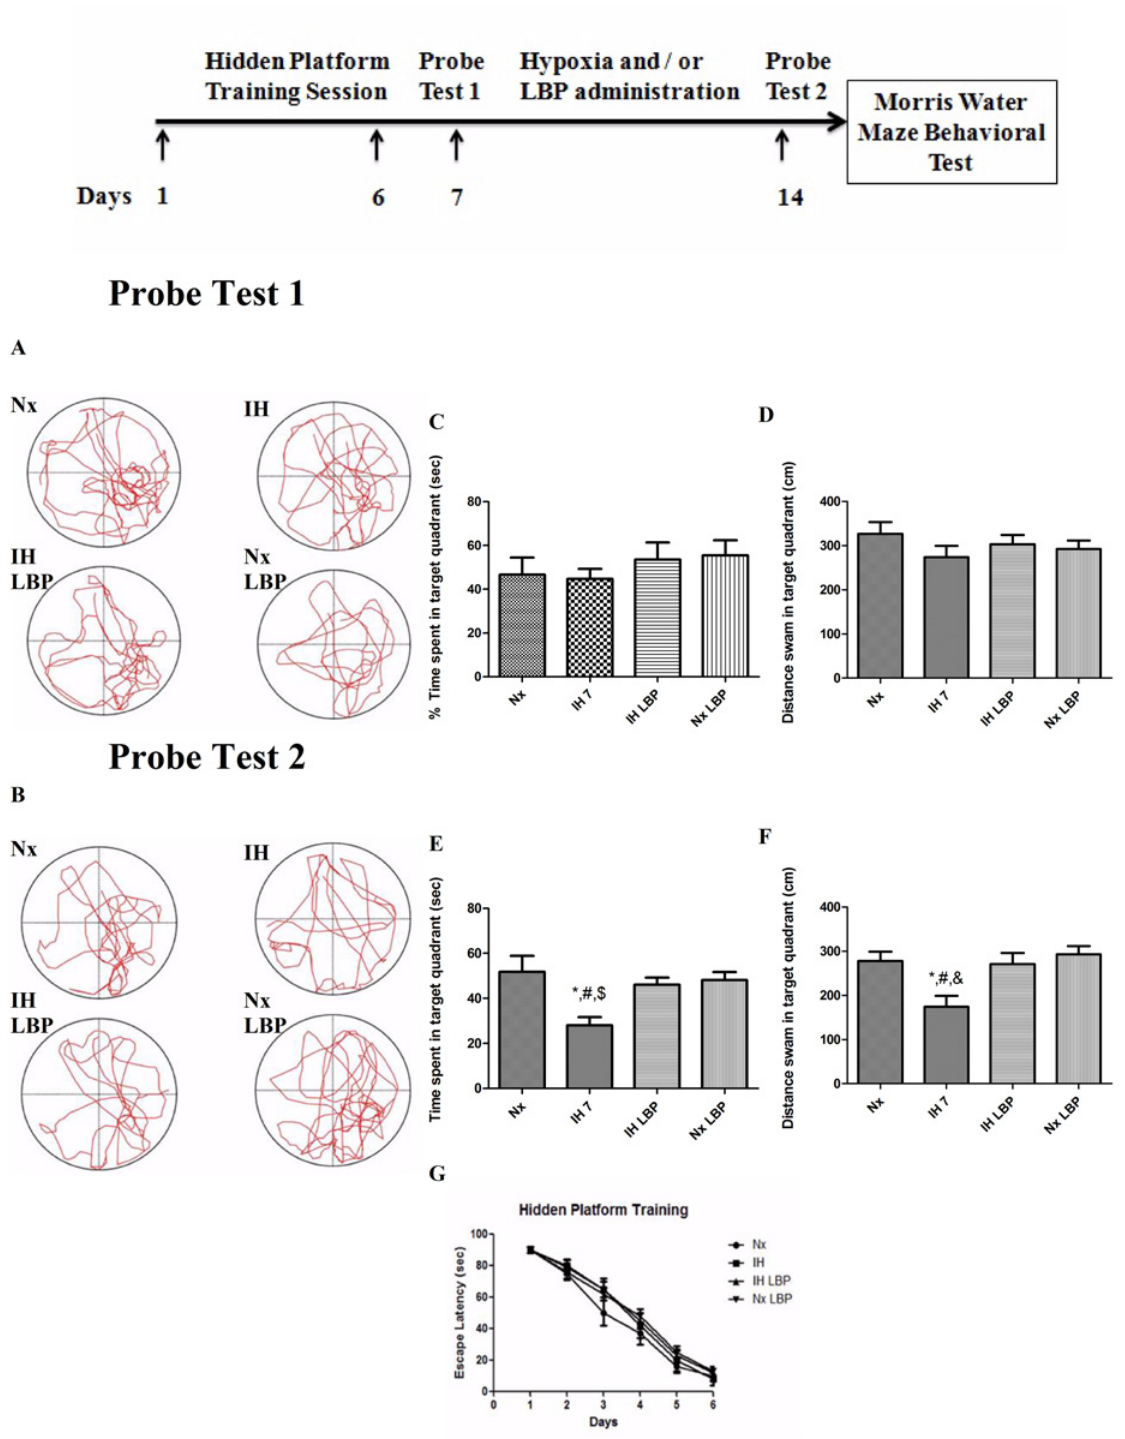
Fig 1. CIH treatment caused remarkable spatial memory loss in rats, which was significantly reversed by LBP administration. Panels A and B represent the tracking paths of the rats in normoxic (Nx) or hypoxic (IH) groups; LBP-treated hypoxic (IH+LBP) or normoxic (Nx+LBP) groups in probe tests 1 and 2, respectively. Panel C, D, E and F summarize the percentage of time spent and distance swam in target quadrant of trained rats. The escape latency of the rats from all groups decreased along the training session (panel G). Data are mean ± SEM (n = 12). * p < 0.05 when compared with Nx, # p < 0.05 when compared with IH+LBP, $ p < 0.05 when compared with Nx+LBP groups.